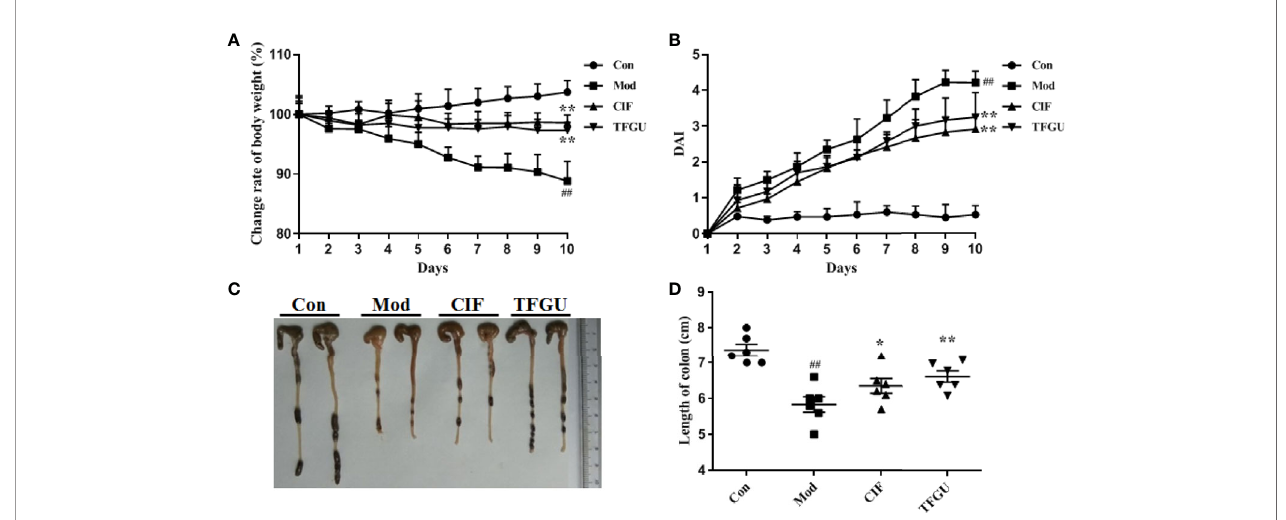
FIGURE 1 | Ameliorative effects of TFGU on CPT-11 – induced colitis in mice. (A) The change rate of body weight. (B) Disease activity index (DAI) was calculated. (C) Macroscopic appearance and (D) the length of colons from each group of mice were measured. Date are shown as mean ± SD (n = 6 mice/group). ## P < 0.01 vs. Con group, while * P < 0.05, ** P < 0.01 vs. Mod